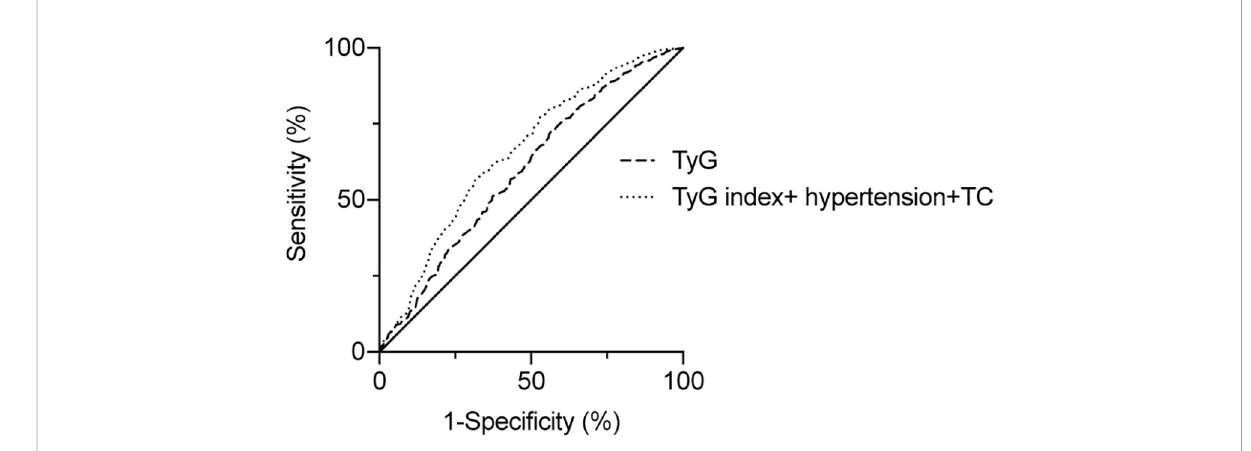
FIGURE 3 ROC curve of the risk AF according to TyG index.